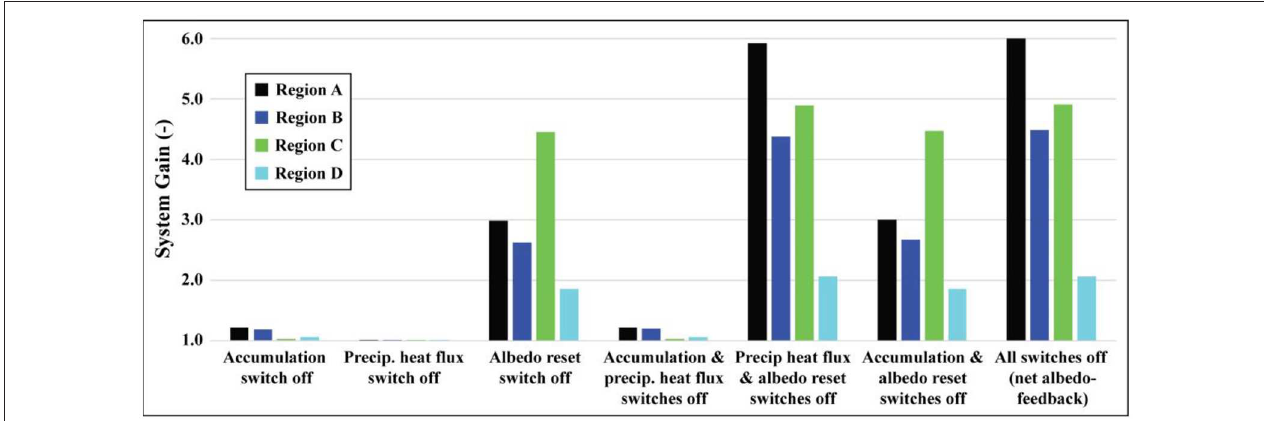
FIGURE 11 | System gains (averaged across the glacier surface) associated with turning each trigger switch off. Gains correspond to the fractional increase in melt due to the inclusion of the trigger process(es).